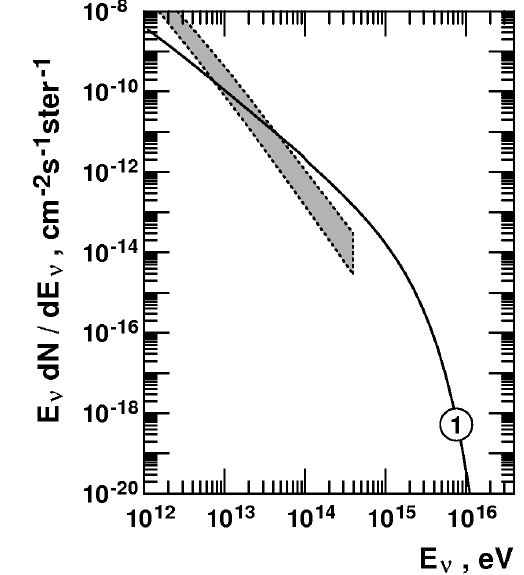
Figure 5: The neutrino flux that corresponds to the gamma ray flux of IC 443. No neutrinos attributed to this sources have been observed